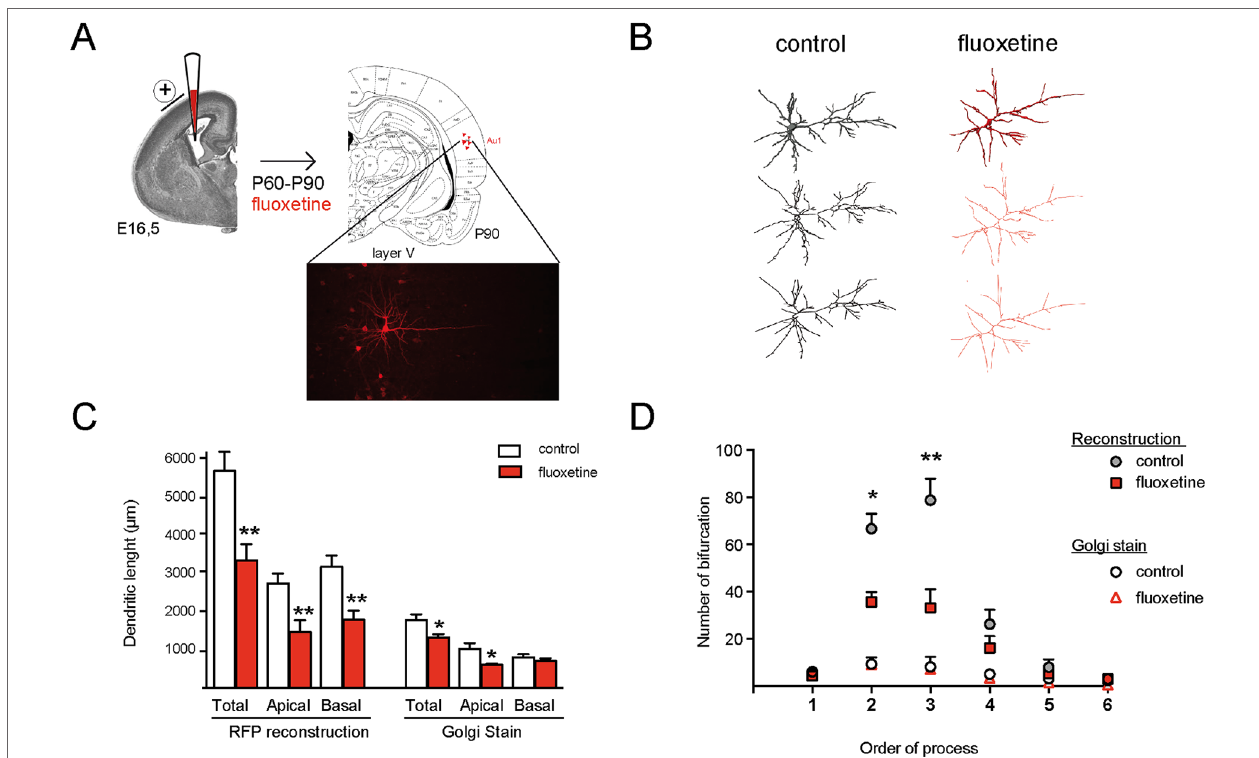
FIGURE 3 | Repetitive flx treatment decreases the dendritic length of pyramidal neurons in the primary auditory cortex of rats. (A) Schematic representation of in utero electroporation to target gene delivery into neurons in the auditory cortex. The inset shows mRFP electroporated pyramidal neurons selected for analysis in layer V of the primary auditory cortex in coronal slices of 150 µm. (B) The 3-dimensional reconstruction of confocal images is shown for isolated neurons obtained from vehicle and fluoxetine-treated animals. Upper panel: raw image; middle panel: skeletonized form; and lower panel: the reduced skeletonized form. (C) Quantifications (mean ± SEM) of the total, apical, and basal dendrites, measured in the skeletonized form of neurons after 3-dimensional reconstruction (left grouped bars) or measured after Golgi staining of the same area (right grouped bars). (D) Quantification of the number of bifurcations according to increasing orders of processes. Value represent mean ± SEM. For 3-dimensional reconstruction, eight control neurons obtained from three animals and seven neurons obtained from three animals were analyzed. * p ≤ 0.05; ** p < 0.01 Mann–Whitney U